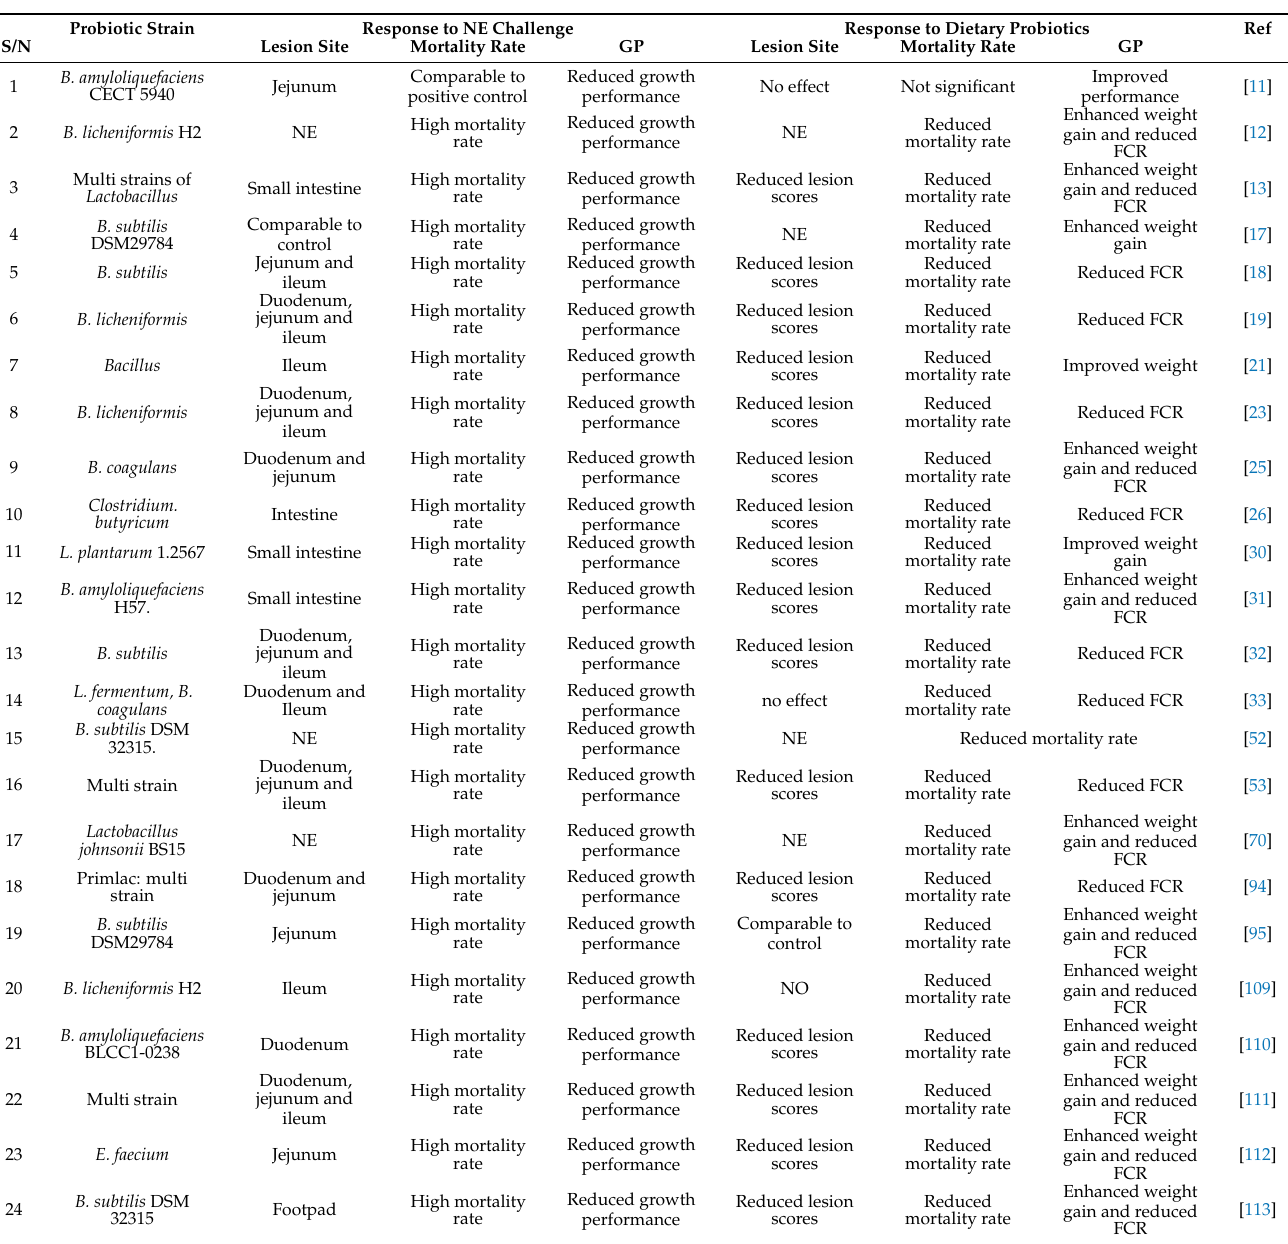
Table 2. Influence of NE challenge on induction of gut lesions, mortality rate, growth performance and the ameliorative effect of